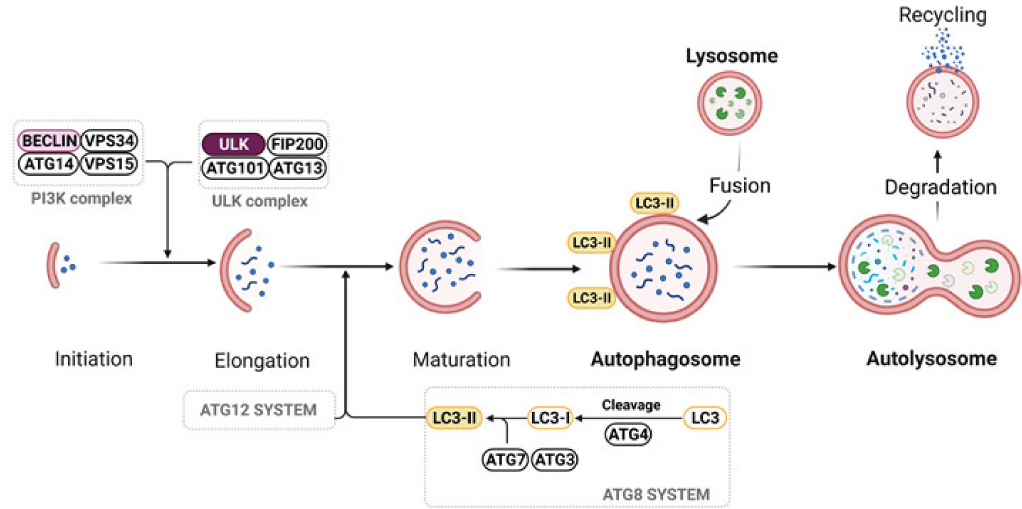
Figure 3. Process of autophagy. Autophagy is initiated by post-translational modifications in ULK1 or phosphatidylinositol- 3-kinase (PI3K) complex. Autophagosomes elongation and maturation are catalyzed by ATG12 and ATG8 system, respec- tively. Formation of LC3-II occurs by proteolytic cleavage of pro-LC3 to LC3-I by ATG4, and then conjugation of LC3 family members to phosphatidylethanolamine (PE) on the surface of autophagosomes catalyzed by ATG7 and ATG3. Formed LC3B-II is a marker of autophagosomes. Mature autophagosomes fuse with lysosomes to form autolysosomes, which degrade cargo to amino acids, fatty acids or nucleotides that can be reused by cells. Created with BioRender.com. Adapted from “Autophagy In Cancer Pathways”, by BioRender.com (2021) (accessed on 1 September 2021). Retrieved from https://app.biorender.com/biorender-templates. accessed on 1 September 2021) [209].